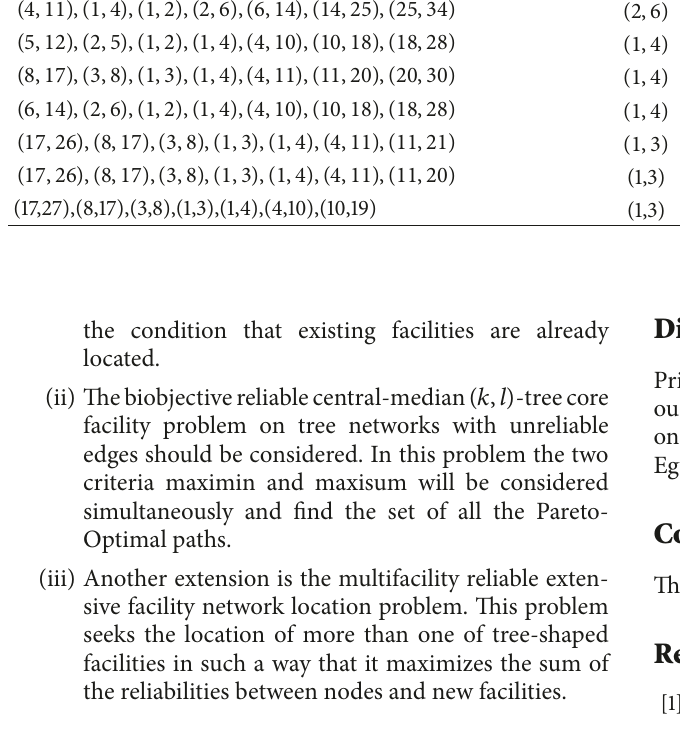
Induced subtree ⟨Λ ⟩ 𝑐